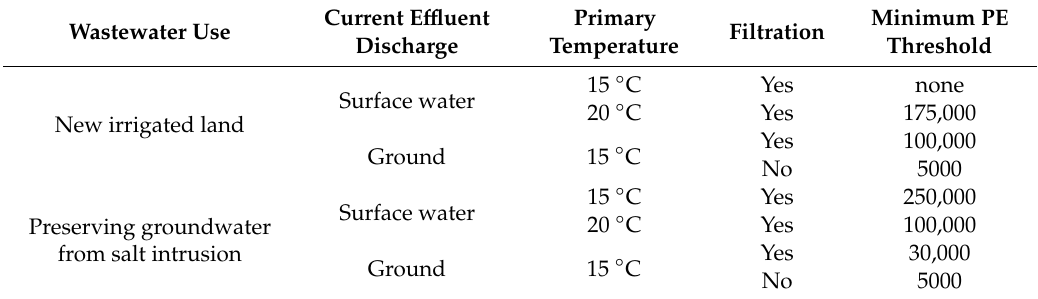
Minimum PE Current E ffl uent Primary Filtration Threshold Discharge Temperature Surface